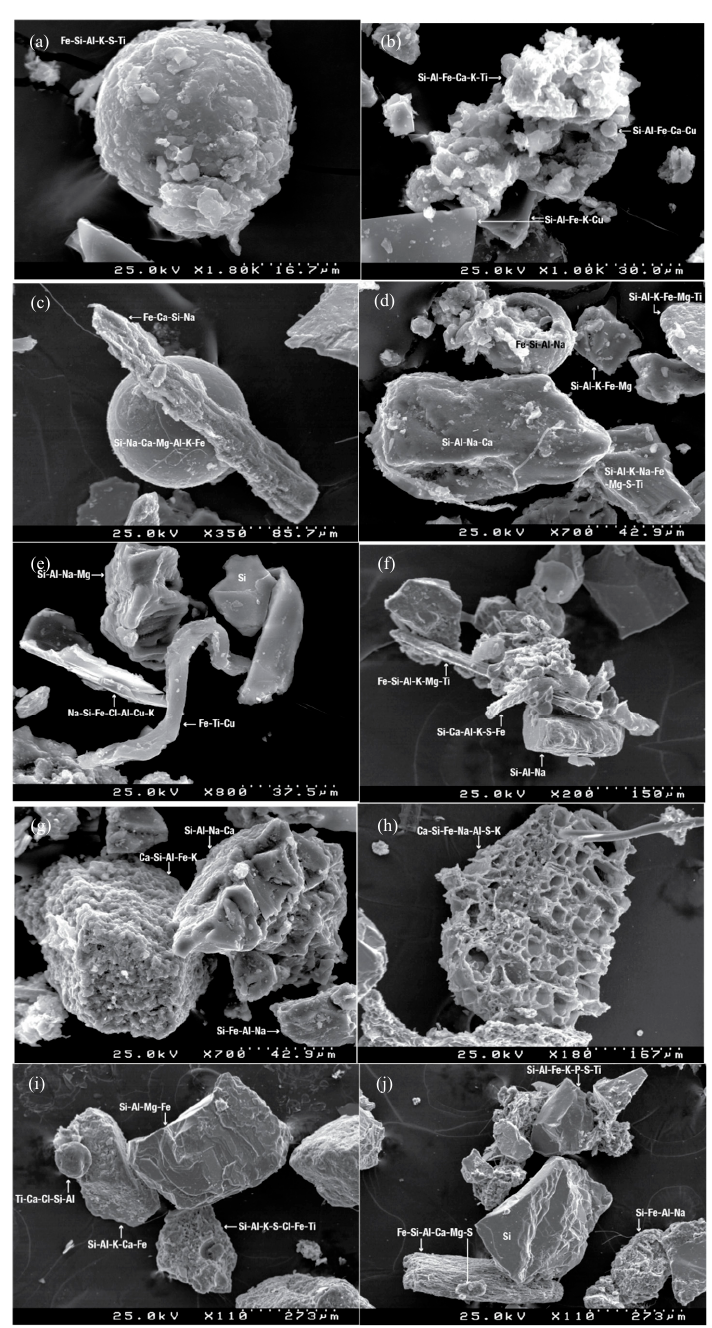
Figure 2. SEM images and composition of anthropogenic and geogenic road dust particles: ( a – f ) plerospheres, cenospheres, aggregates, plate like particles and fibrous steel with considerable plastic deformation and fragmentation; ( g ) irregular aggregates; ( h ) porous Ca-Si-Fe rich particle; ( i , j ) well-formed